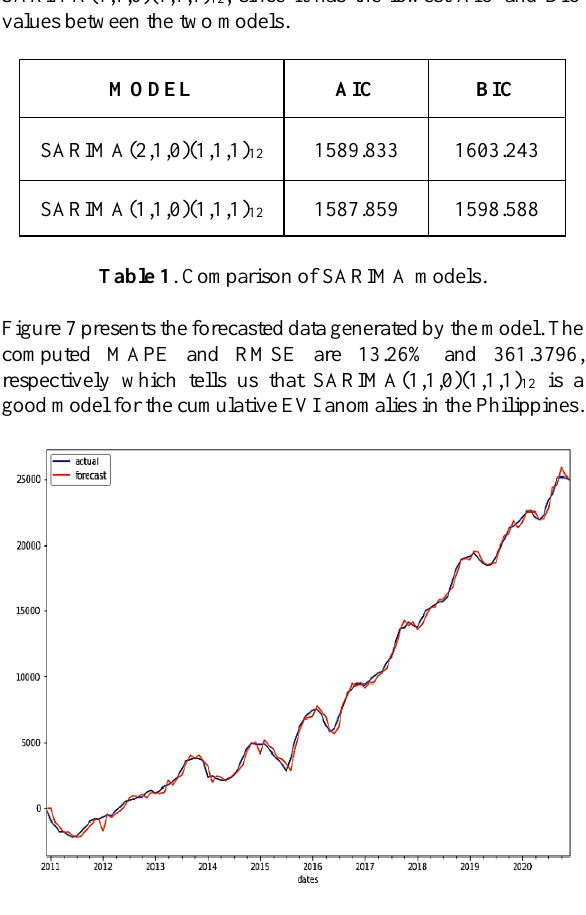
Figure 7. Forecasted and actual cumulative EVI